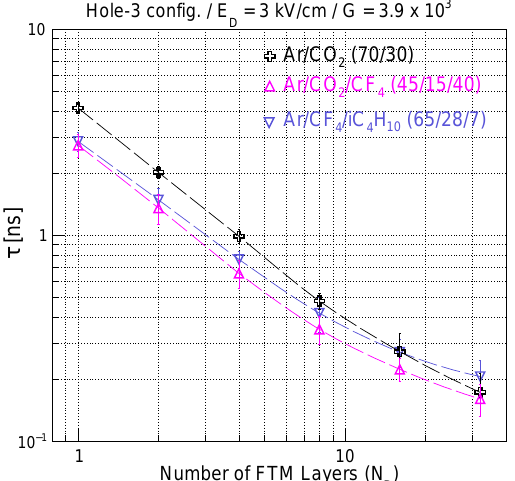
Figure 5. Time resolution for different gas mixtures at an sequivalent total charge. A time resolution of 160 ps is obtained with Ar/CO 2 /CF 4 (45/15/40) in a 32-layer